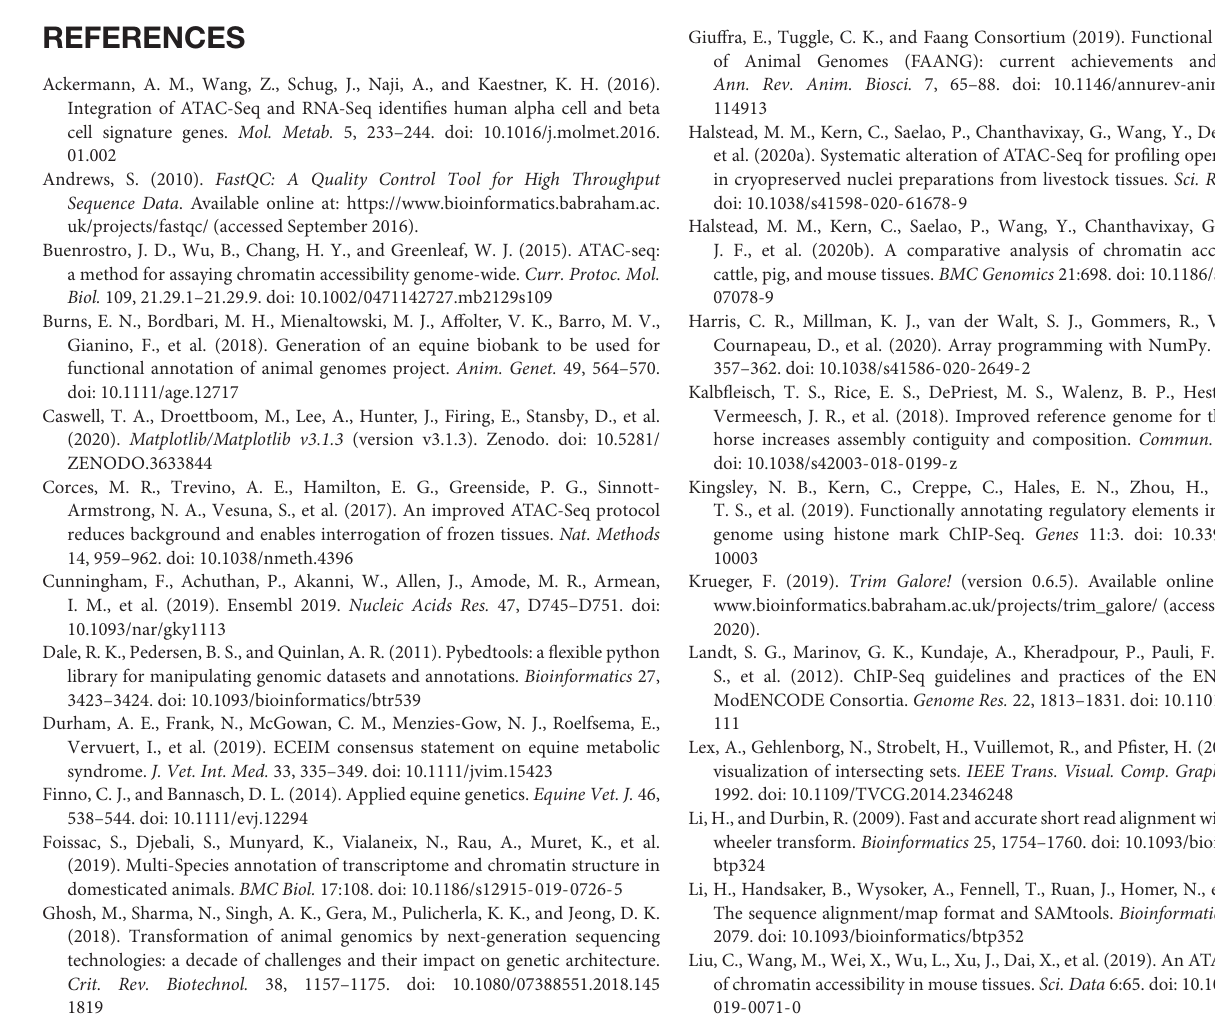
Supplementary Figure 1 | Fragment size distributions of libraries from L1 as determined by sequencing and Fragment Analyzer. Supplementary Figure 2 | Fragment size distributions of libraries from L2 as determined by sequencing and tapestation. Supplementary Figure 3 | Duplication and mitochondrial contamination rates. (A) Total, mitochondrial, and unique nuclear read counts of all libraries; (B) Comparison between first sequencing run (left) and combined reads (right) from L1 liver CN libraries; (C) Fingerprint plot of L1 CN liver libraries. Supplementary Figure 4 | MACS2 peak calling statistics. (A) Number of peaks, (B) peak length distribution, (C) peak score distribution, and (D) percent of genome covered by peaks for each library. (E,F) Peak metrics assessed using ChIP-seq dataset in liver (E) and lamina (F)